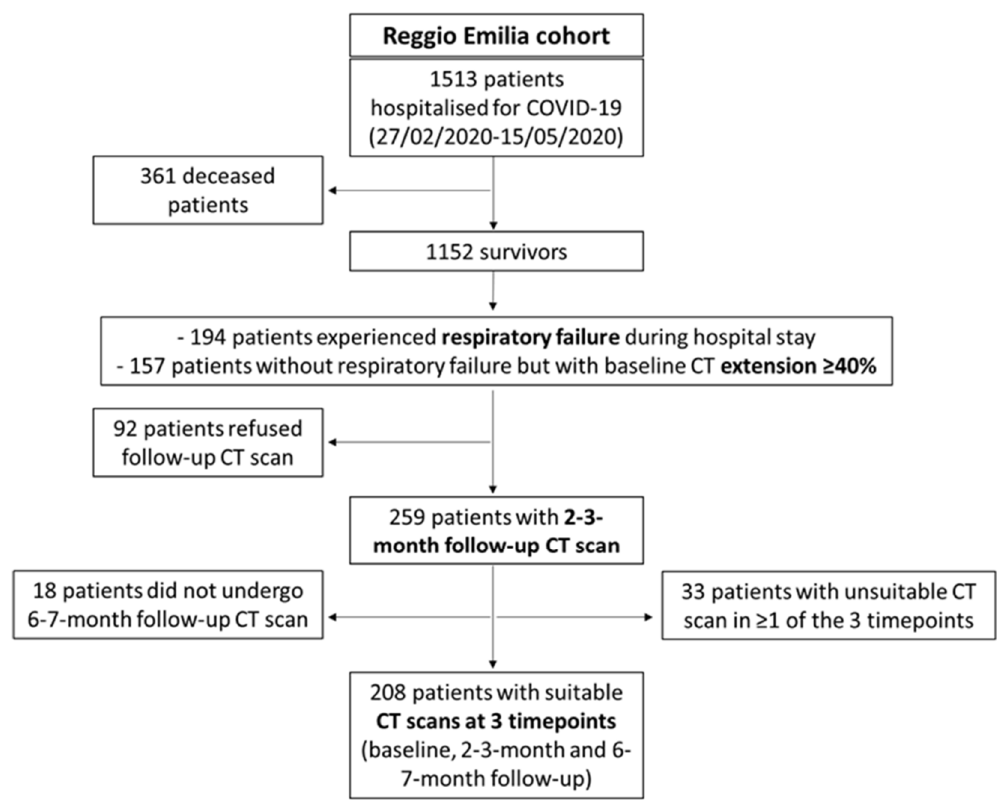
Figure 1. Patient inclusion and exclusion flow chart.